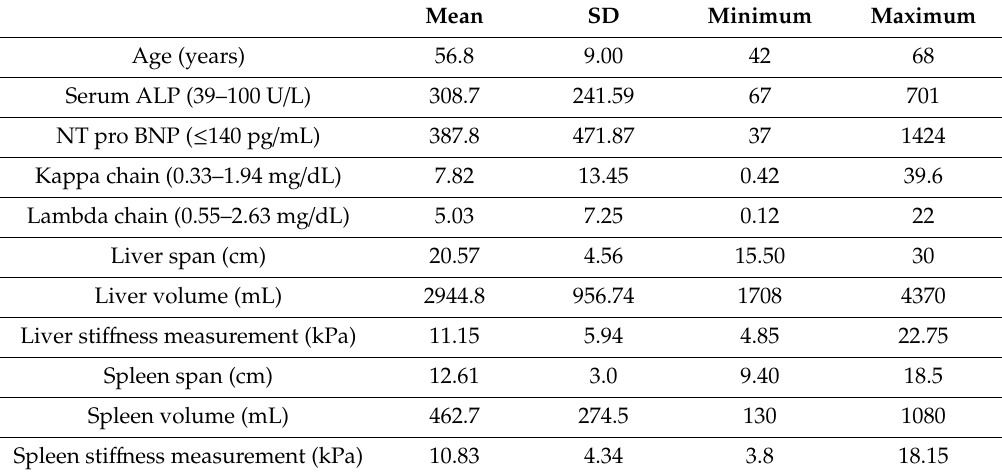
Table 1. Laboratory test results and liver and spleen size and sti ff ness measurements.